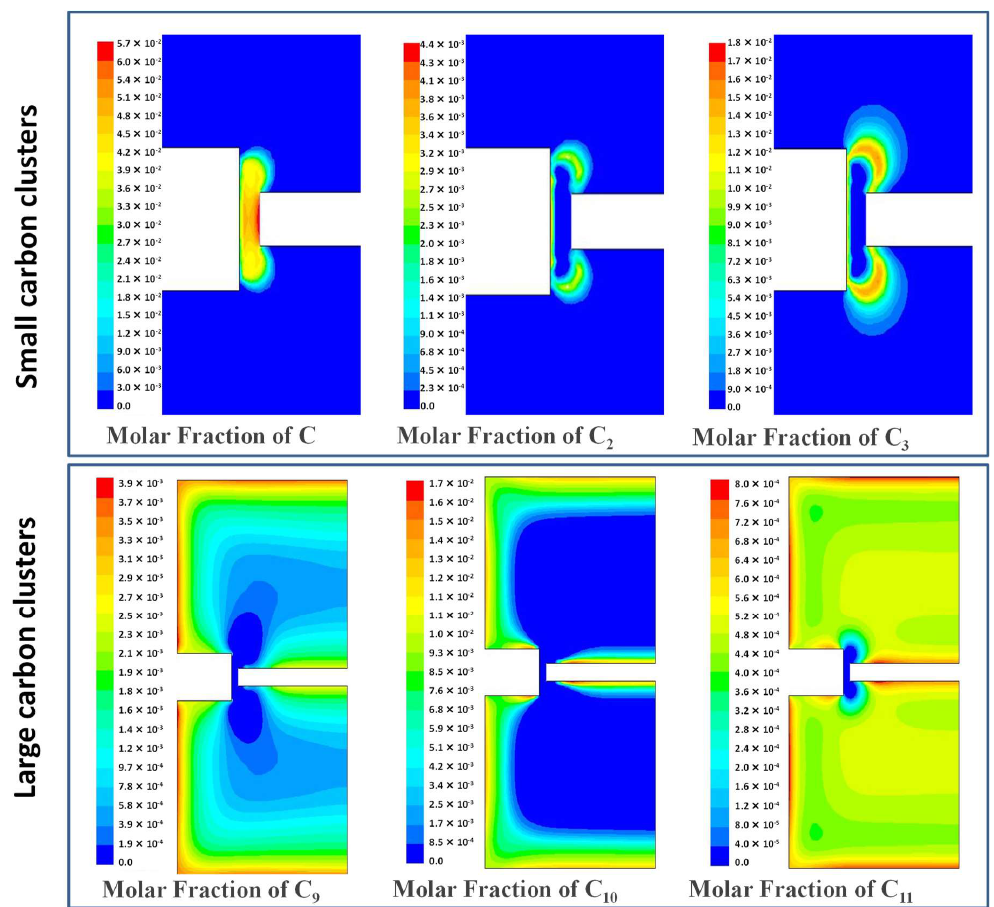
Figure 13. Simulated mole fractions of small carbon clusters C–C 3 and higher mass carbon cluster C 9 –C 11 at 150 A.